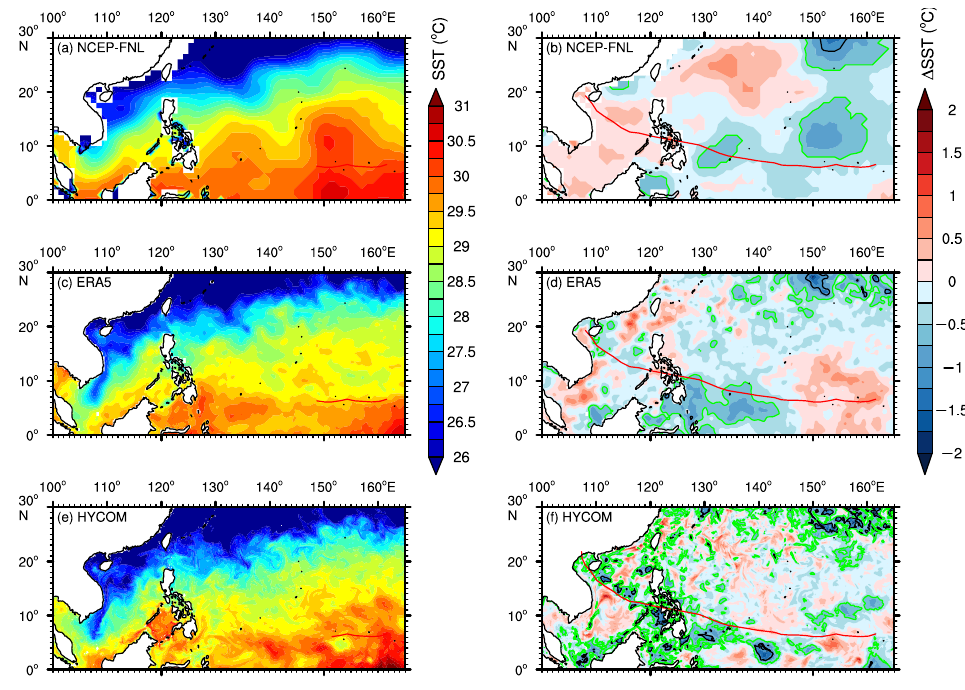
Figure 8. Sea surface temperature during super-typhoon Haiyan in atmospheric and oceanic analy- sis/reanalysis. ( a , b ) NCEP-FNL, ( c , d ) ERA5, ( e , f ) HYCOM. Left panels ( a , c , e ) are the initial SST for typhoon Haiyan (4_12Z), and right panels ( b , d , f ) are the SST change after the passage of typhoon Haiyan (10_12Z). The contours represent 0.5 ◦ C (green) and 1.0 ◦ C (black) cooling.